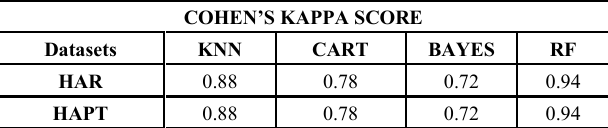
Figure 5. Recognition accuracies of proposed approach with existing techniques using HAPT